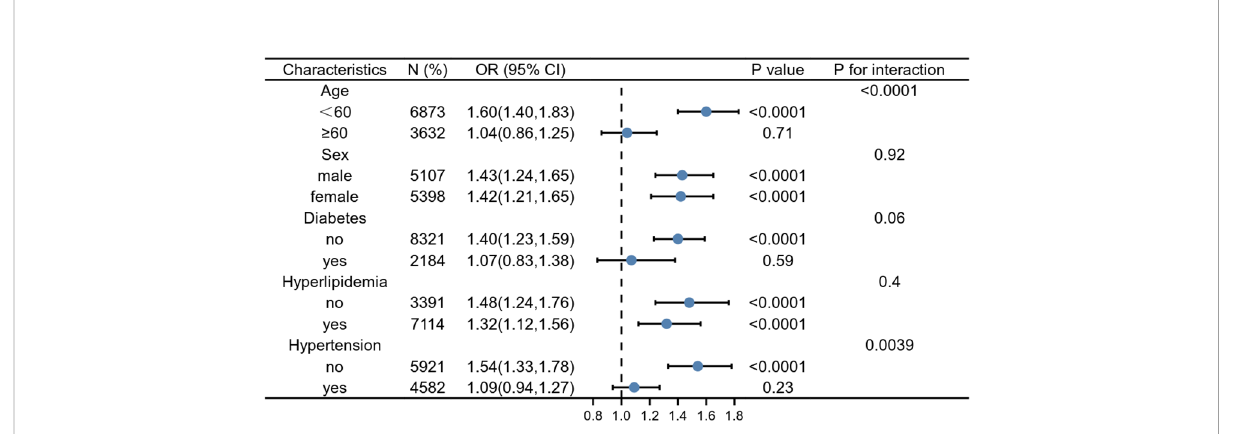
FIGURE 2 Subgroup analysis for the association between SII and hepatic steatosis. Weighted univariate logistic regression was used for subgroup analysis.